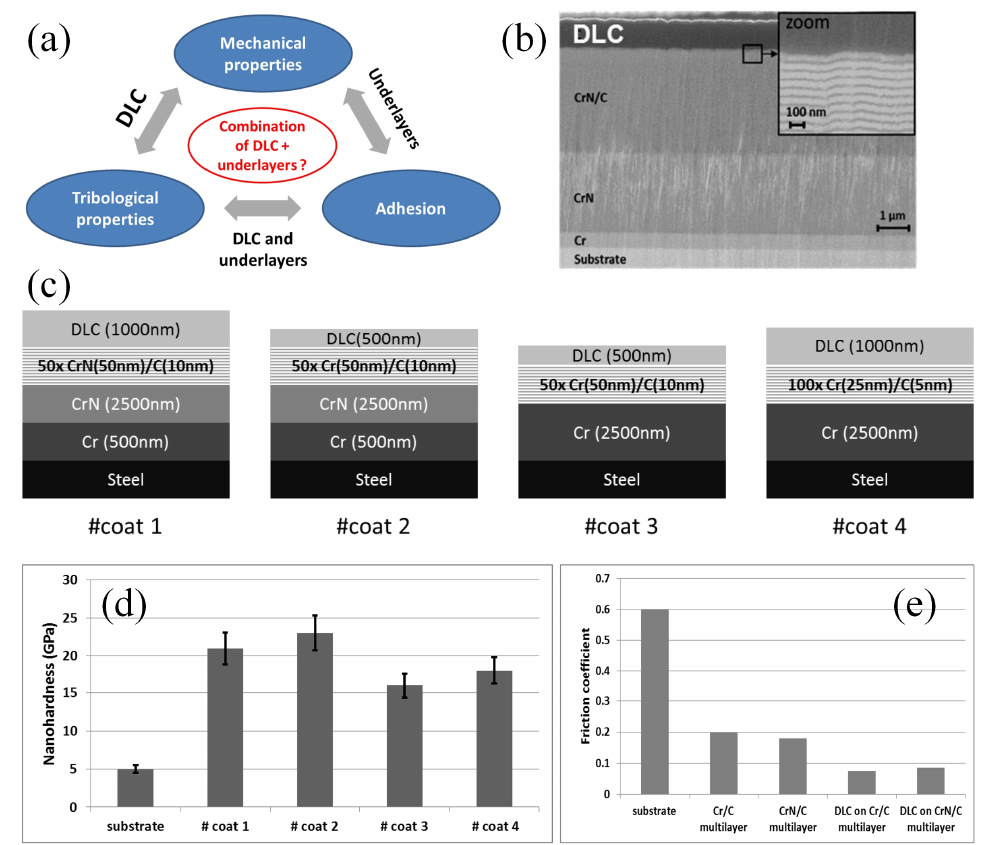
Figure 4. ( a ) Relationships between underlayers and the properties in a DLC-based multilayer coating; ( b ) the cross-sectional morphology of multilayer coating; ( c ) structure of multilayer coatings with different underlayers; ( d ) hardness of different multilayer coatings; ( e ) COF of different multilayer coatings. Reprinted with permission from [93].